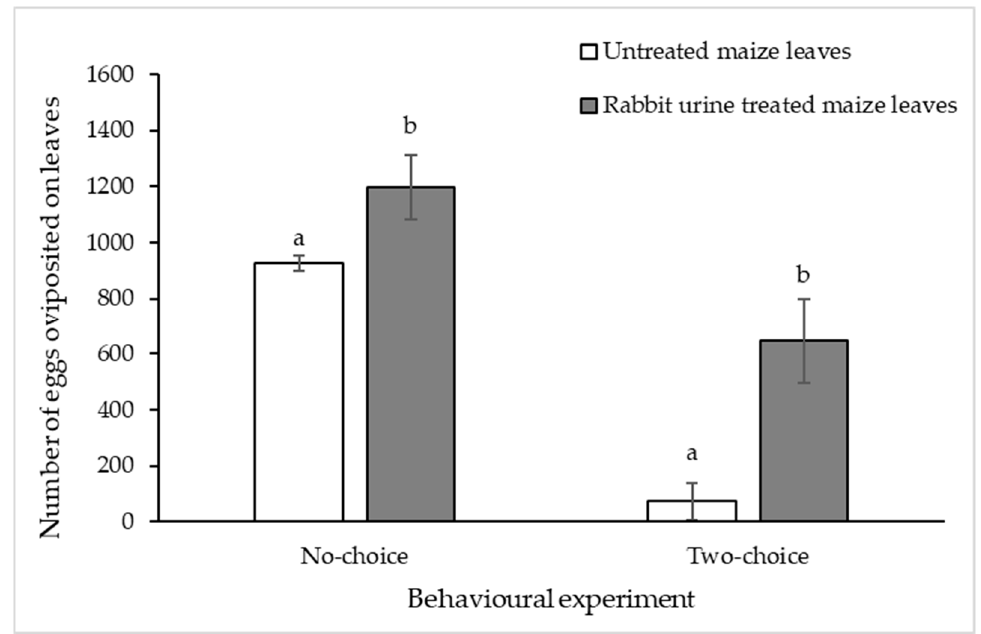
Figure 7. Mean number of eggs oviposited by the gravid female FAW moth on maize leaves treated with rabbit urine and distilled water in no-choice and two-choice behavioral experiments. Error bars represent standard errors. Different small letters above the error bars represent a significant difference between treatments at p = 0.05, according to the Tukey test.